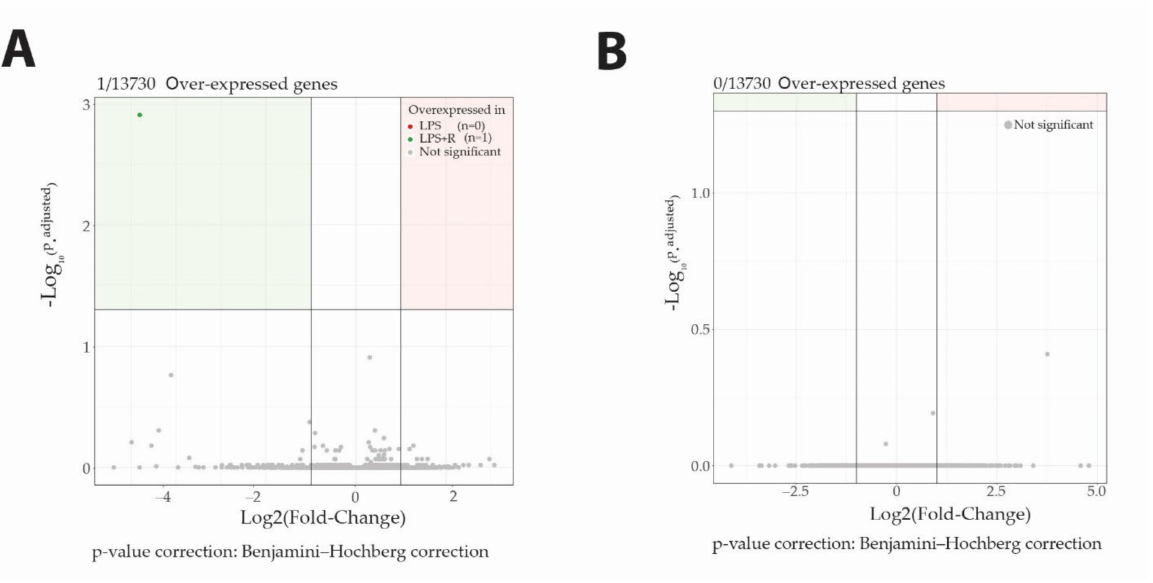
Figure 5. Neither fluidotherapy nor NButGT treatments affected gene transcription after LPS injection in rats. Volcano plot representation of log2FoldChange calculation and statistical differences with Log 10 (p.adjusted) of LPS vs. LPS + R comparison ( A ) and LPS + R vs. NButGT comparison ( B ). Genes were considered differentially expressed when matching the following criteria: log2FoldChange >1 or log2FoldChange < − 1 and Significance (p.adjusted)